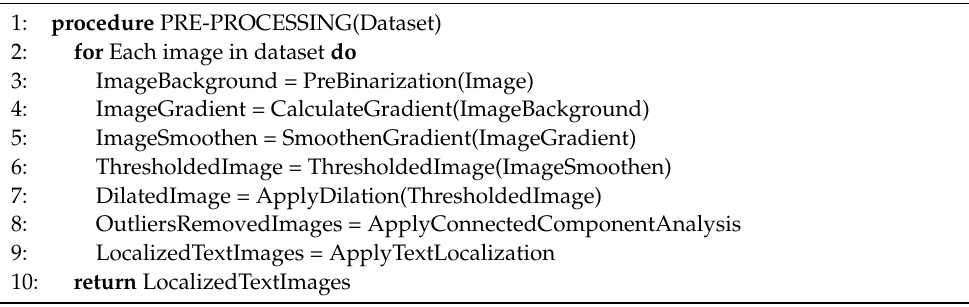
Algorithm 1 Proposed algorithm used for Data